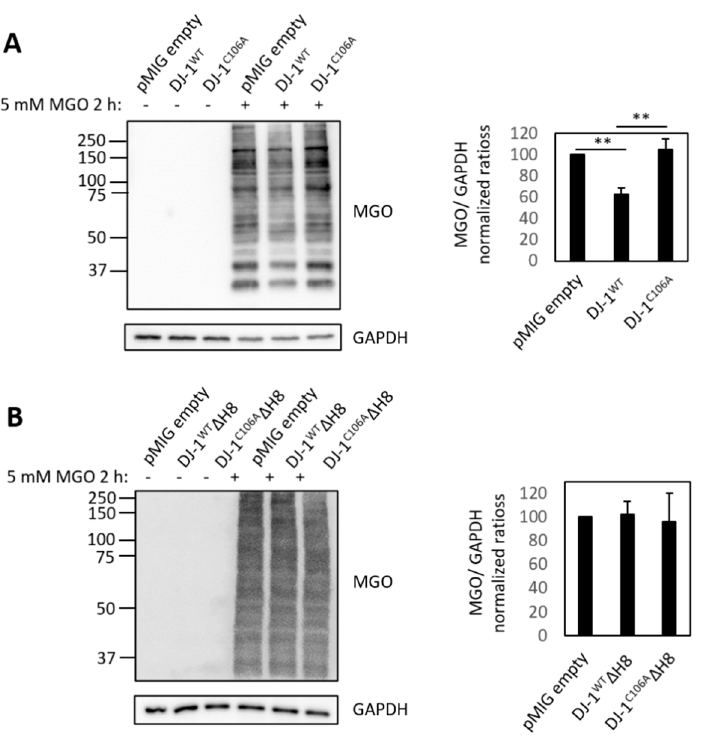
Figure 5. Effect of DJ-1 on protein glycation: Effect on protein glycation by overexpression of ( A